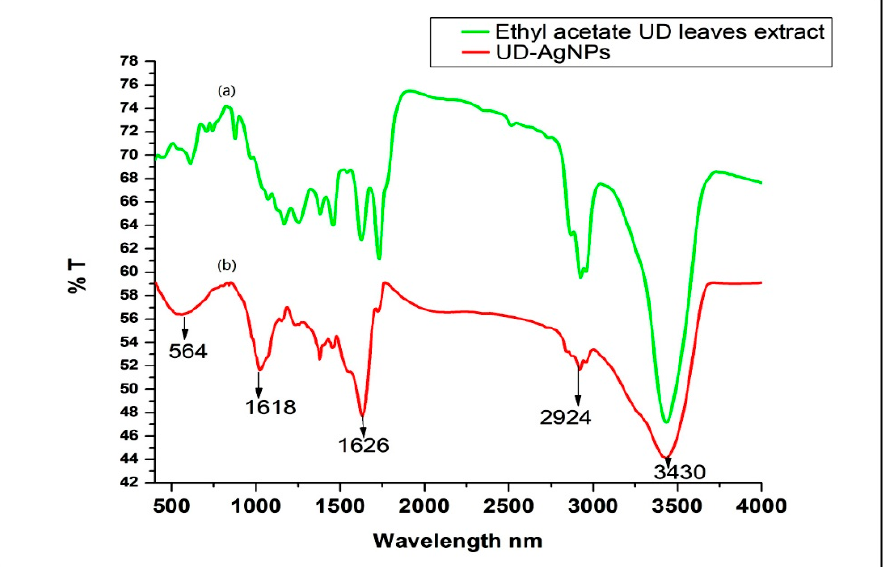
Figure 3. FTIR spectrum. ( a ) Ethyl acetate UD leaves extract; ( b ) UD-AgNPs with different functional groups.